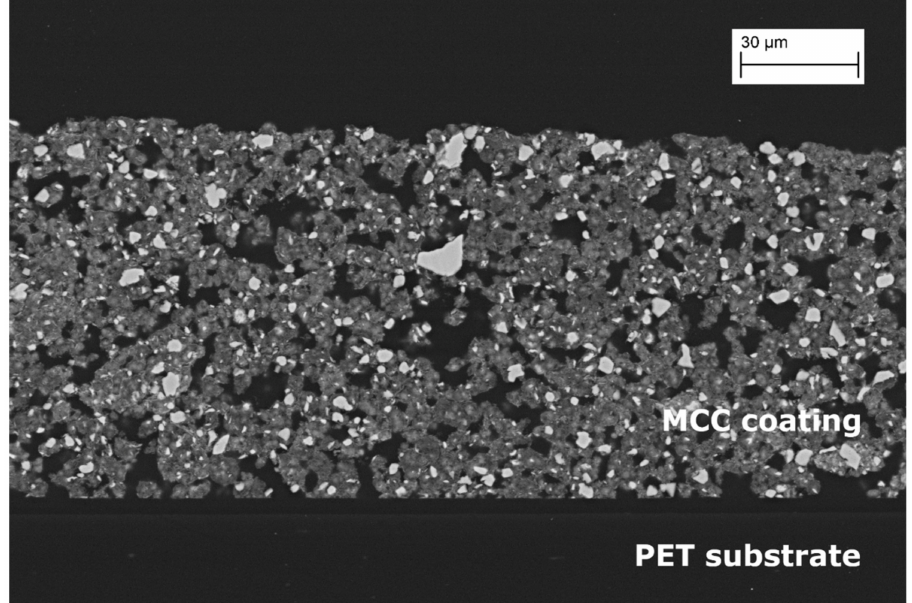
Figure 1. Cross section SEM image of the obtained FCC porous coating on PET, porous